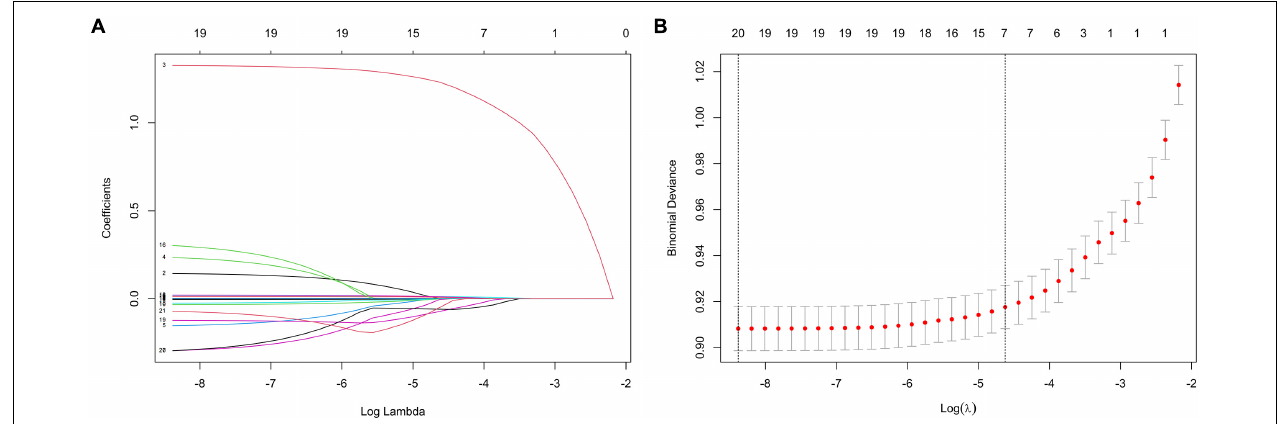
FIGURE 1 | Features selection by LASSO. (A) LASSO coefficients profiles (y-axis) of the 20 features. The upper x-axis shows the average numbers of predictors and the lower x-axis shows the log( λ ). (B) Fivefold cross-validation for tuning parameter selection in the LASSO model.